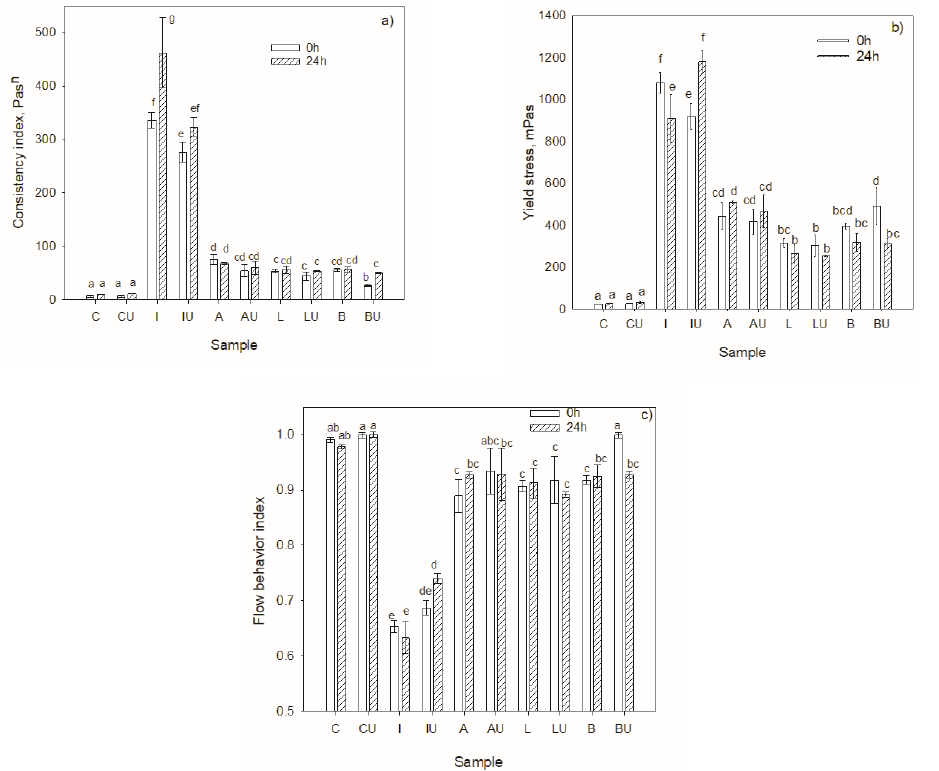
Figure 4. The parameters of the Herschel–Buckley model of the ice cream mix before and after maturation (for 24 h; at 4 °C): ( a ) the consistency index, ( b ) yield stress, ( c ) the flow behaviour index. The different superscript letters represent significant differences in the means of the same parameter ( p < 0.05).